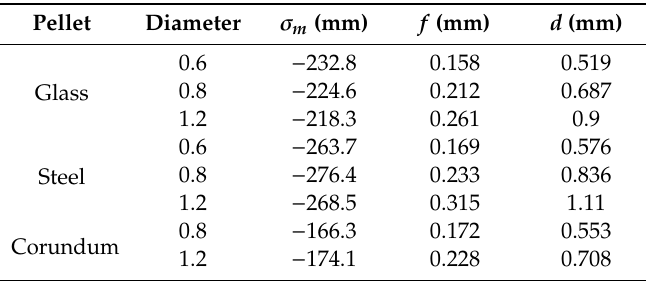
Table 5. Characteristics of residual stress fields with di ff erent shot peening